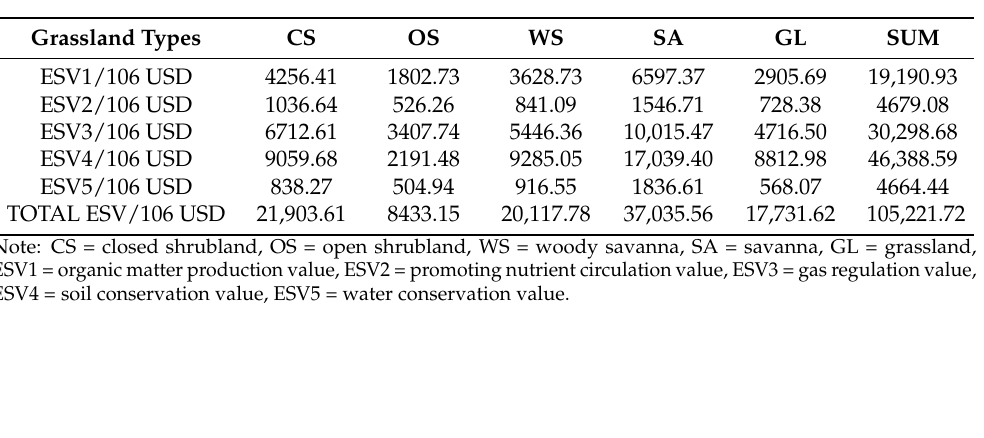
Table 4. Statistics of ecosystem service value of grassland types for different